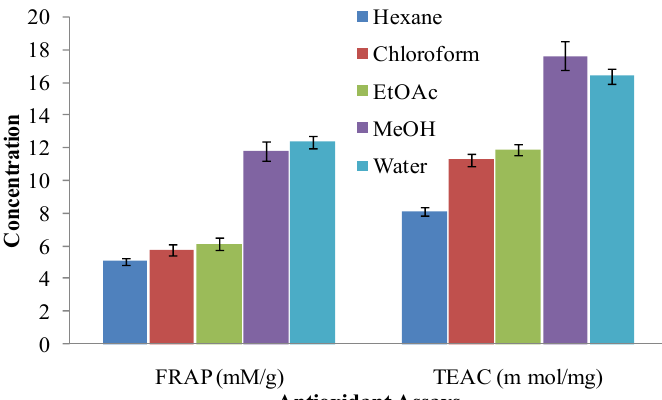
Figure 2. Ferric reducing antioxidant power and trolox equvilant antioxidant capacity of various solvent extracts of Artimisia annua